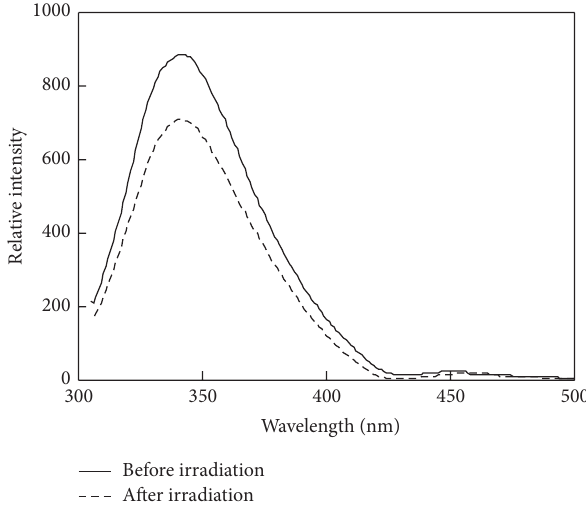
Figure 3: Fluorescence spectra of the tryptophan residue of HSA. The sample solution containing HAS (10 𝜇 M) and 7a (10 𝜇 M) in a sodium phosphate buffer (10mM, pH 7.6) was irradiated for 30